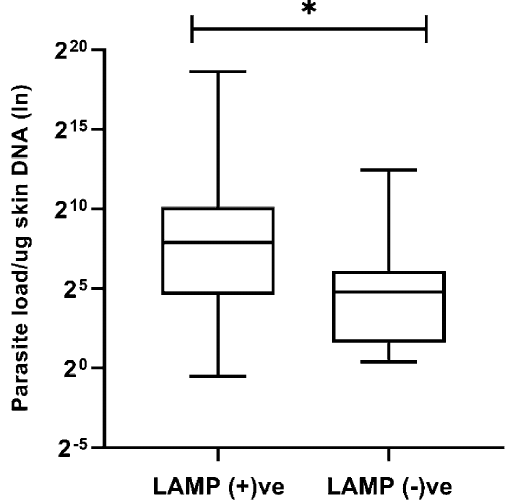
Figure 5. Difference in parasite loads between boil &spin LAMP positive and negative cases.